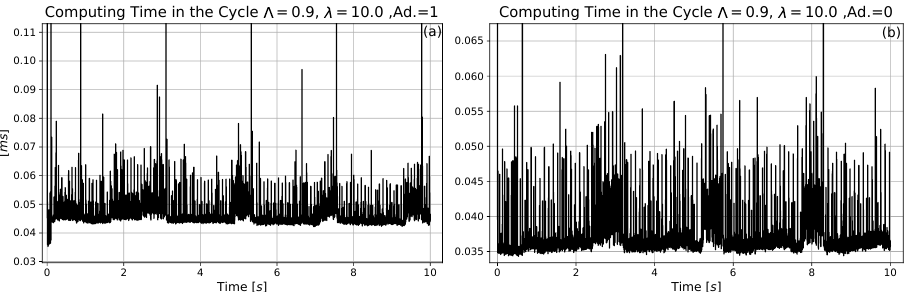
Figure 18. The computational time of the control cycles in ms units (zoomed in excerpts). ( a ): Adap- tive. ( b ): Non-adaptive.